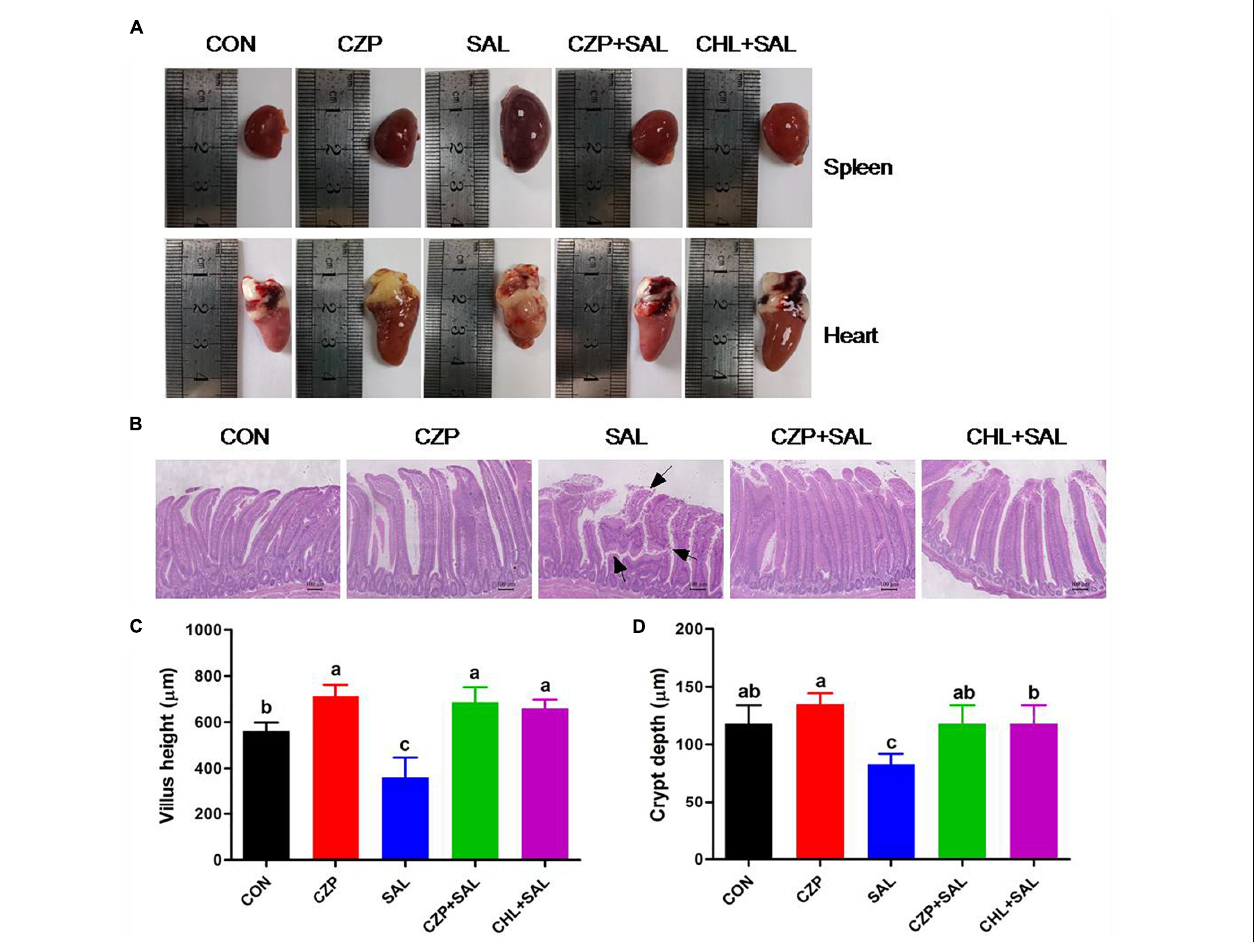
FIGURE 3 | Cu/Zn-Pal-1 ameliorates S. Typhimurium-induced viscera lesions and intestinal mucosa damage. (A) Anatomical morphology of the spleen and heart in chickens from each group. (B) Histological examination of the duodenum mucosa. Scale bar, 100 µ m. The areas marked with an arrow show villous shedding and intestinal mucosa injury induced by S. Typhimurium. (C) Villus length in the duodenum ( n = 6/group). (D) Crypt depth in the duodenum ( n = 6/group). Data are expressed as the mean ± SD. Significant differences were identified using one-way ANOVA statistical analysis ( p < 0.05). Different letters indicate that the changes between groups are statistically